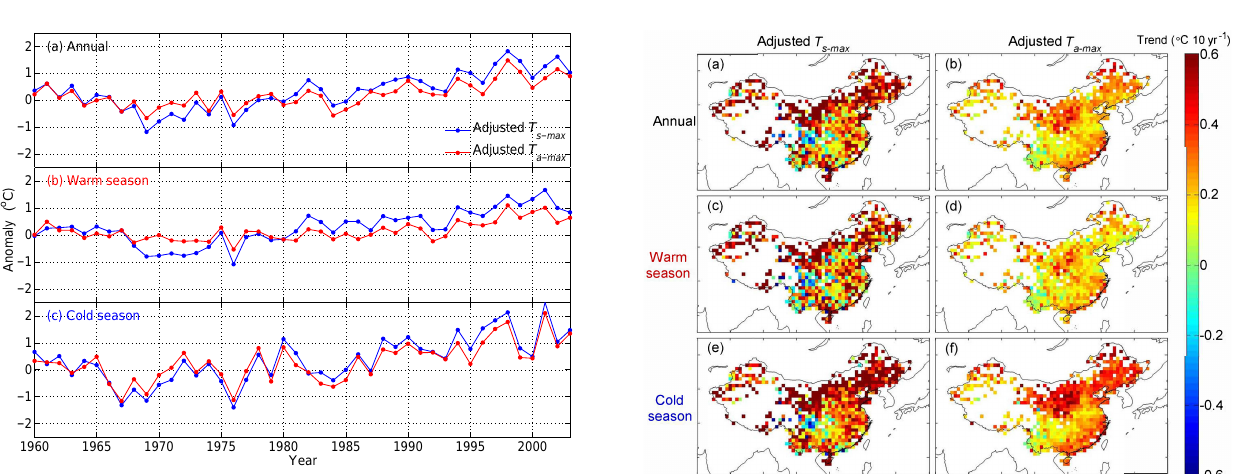
Figure 8. Maps of the trends of the monthly anomalies for the daily maximum land surface temperature ( T s-max , (a, c, e) ) and daily maximum air temperature ( T a-max , (b, d, f) ) for the annual, warm, and cold seasonal scales after adjusting for the effects of surface solar radiation ( R s ) and precipitation ( P) . We used Eq. (1) to si- multaneously adjust the effects of R s and P on T s-max and T a-max and then analyzed the changes in the secular trends of T s-max and T a-max (Sect.